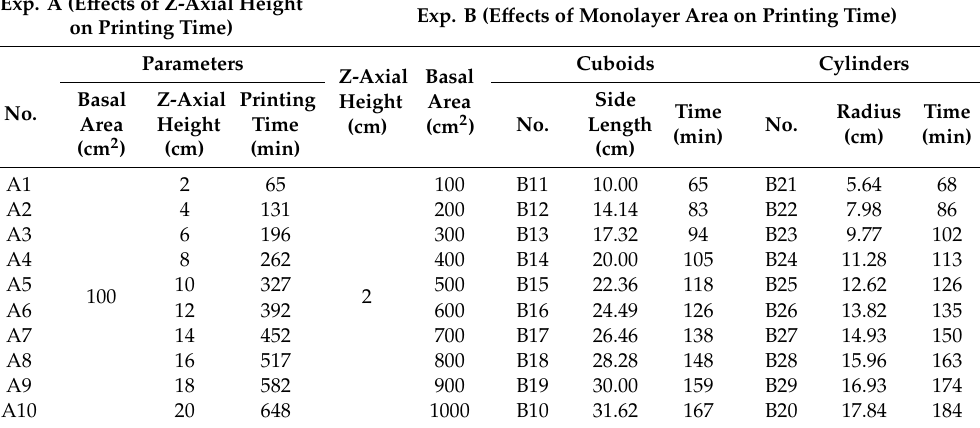
Table 1. Selected parameters and obtained printing time of